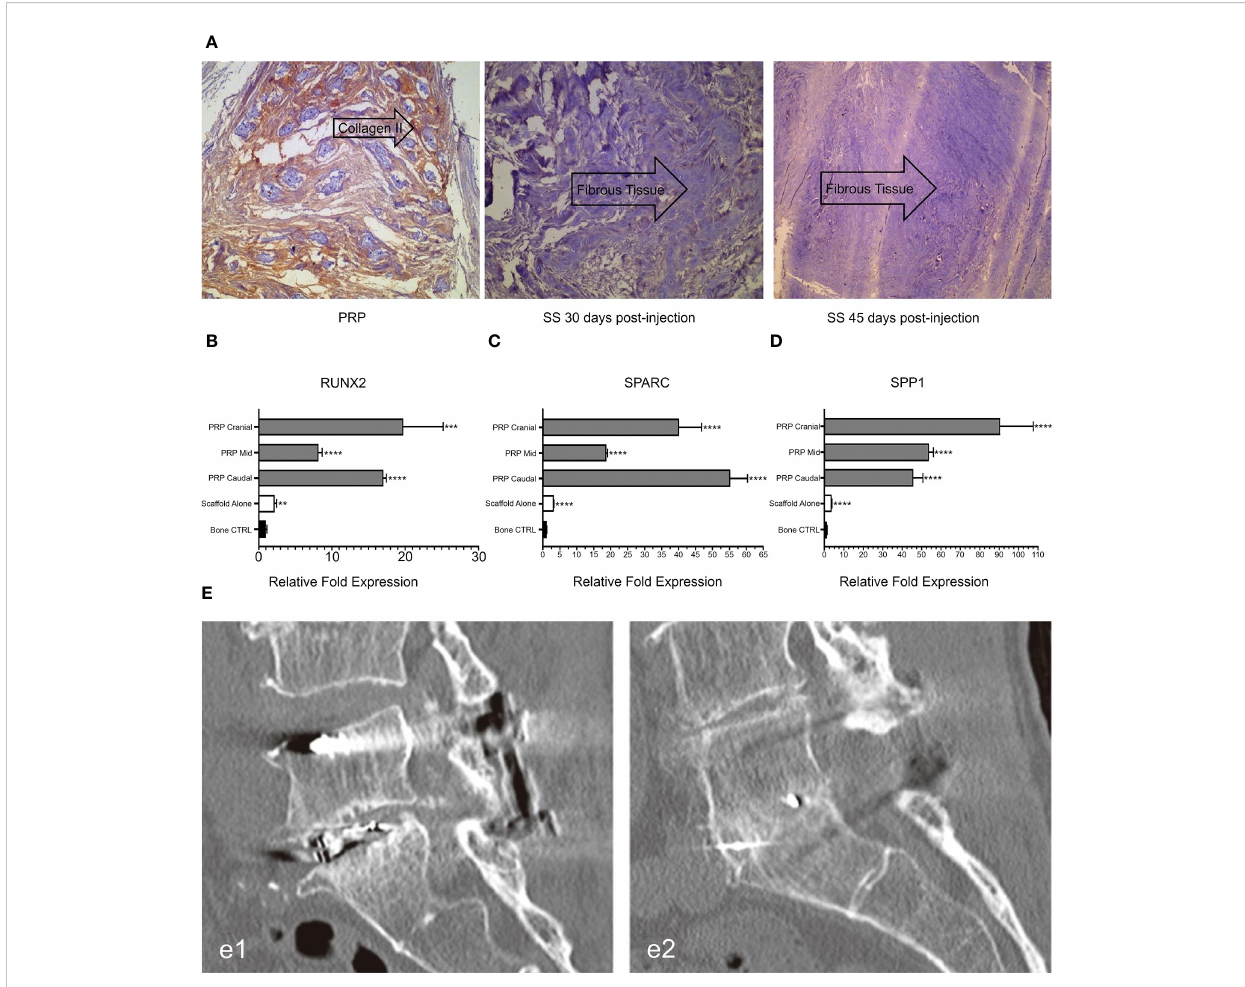
FIGURE 5 (A) Immunohistochemical expression of type II collagen in intervertebral disc tissues at different time points after injection. (B-D) Analysis of osteogenic gene expression. (E) CT evaluation of spinal fusion in different groups. Reproduced with permission from (96 – 98). **P = 0.0034, ***p = 0.0002, ****p < 0.0001. e1: Control group. e2: PRP